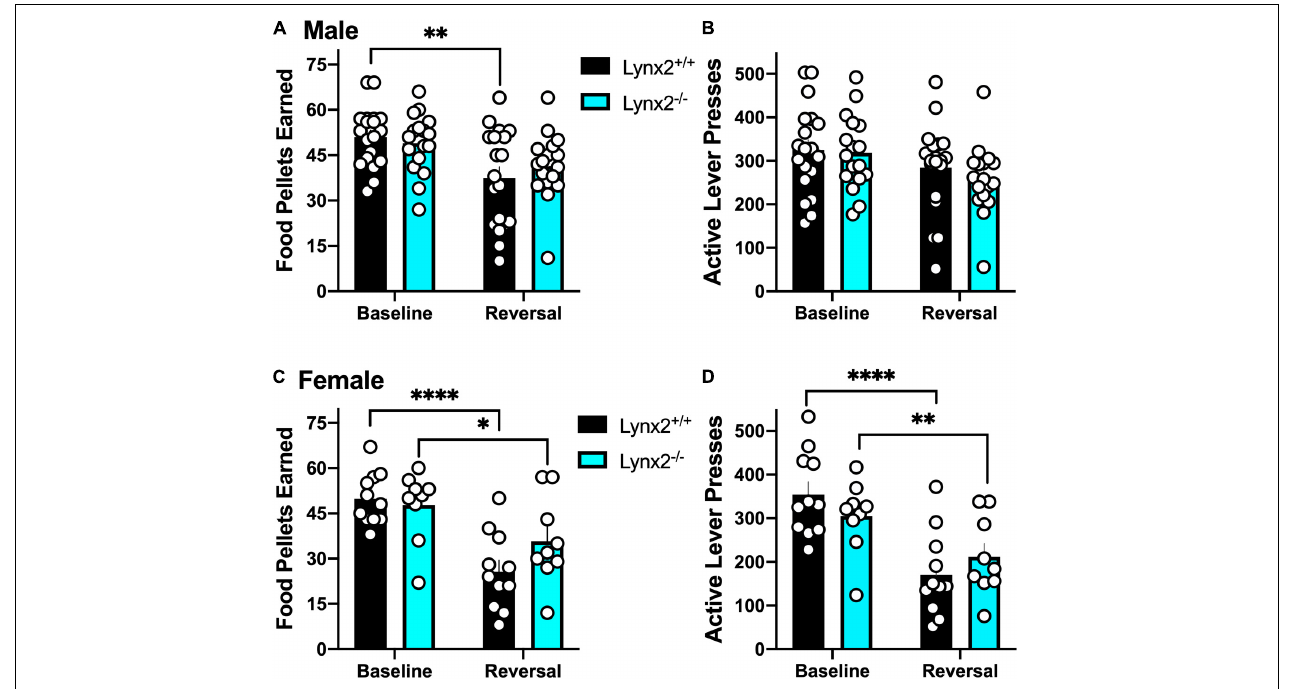
FIGURE 5 | Assessment of the role of lynx2 in cognitive flexibility. (A,B) Male lynx2 − / − and lynx2 + / + mice ( n = 17–19/group) were examined in the reversal learning task. The lynx2 + / + mice displayed a significant decrease in the number of food pellets earned (A) , but no difference in the number of active lever presses (B) , comparing the reversal session to the baseline day. (C,D) Both lynx2 + / + and lynx2 − / − female mice ( n = 9–11/group) exhibited a significant decrease in number of food pellets earned (C) and active lever presses (D) in the reversal session compared to their baseline level of responding. ∗ p < 0.05, ∗∗ p < 0.01, ∗∗∗∗ p < 0.0001. Individual data points shown as white circles, and the bars represent mean ± SEM.